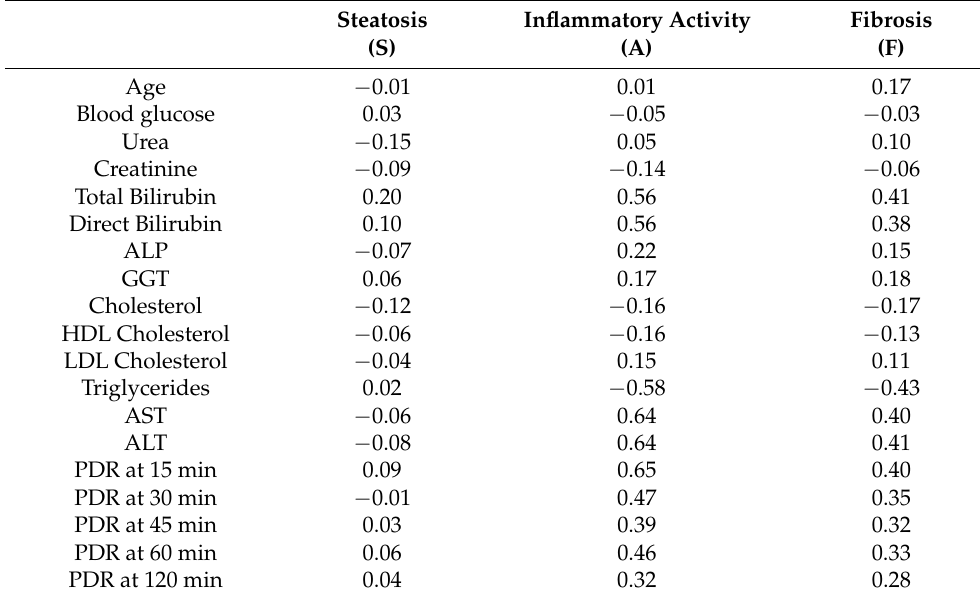
Table 4. Bivariate analysis (Spearman’s Rho) with the SAF